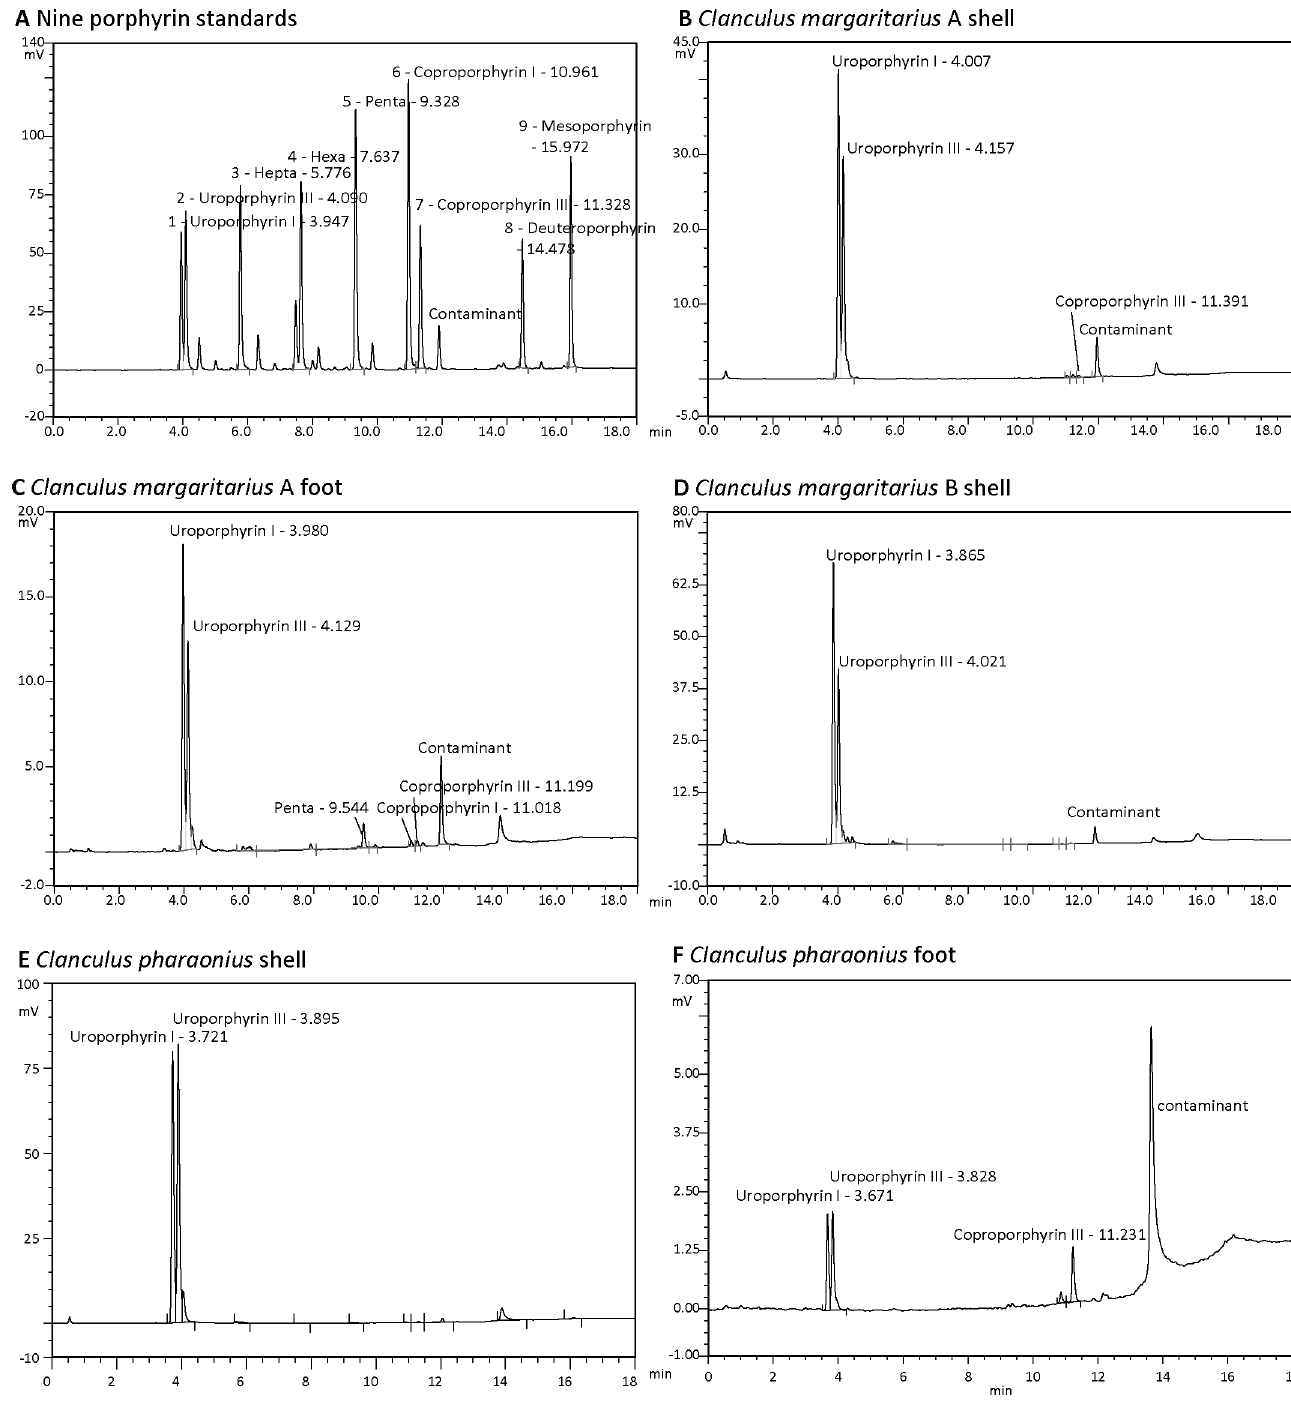
Fig 4. HPLC analyses for porphyrins in Clanculus . (A) Chromatogram of nine porphyrin standards. (B, C) Clanculus margaritarius A. (B) Chromatogram of shell extract (specimen #3, 1:20 dilution). (C) Chromatogram of extract from coloured foot tissue (preserved in RNALater) (specimen #3). (D) Chromatogram of C . margaritarius B shell extract (specimen #9, 1:5 dilution). (E) Chromatogram of shell extract of Clanculus pharaonius (specimen #2). (F) Chromatogram of extract from foot tissue of Clanculus pharaonius (specimen # 1). Note that (B) and (C) were run on the same day as the standards shown in (A); other samples were run on different